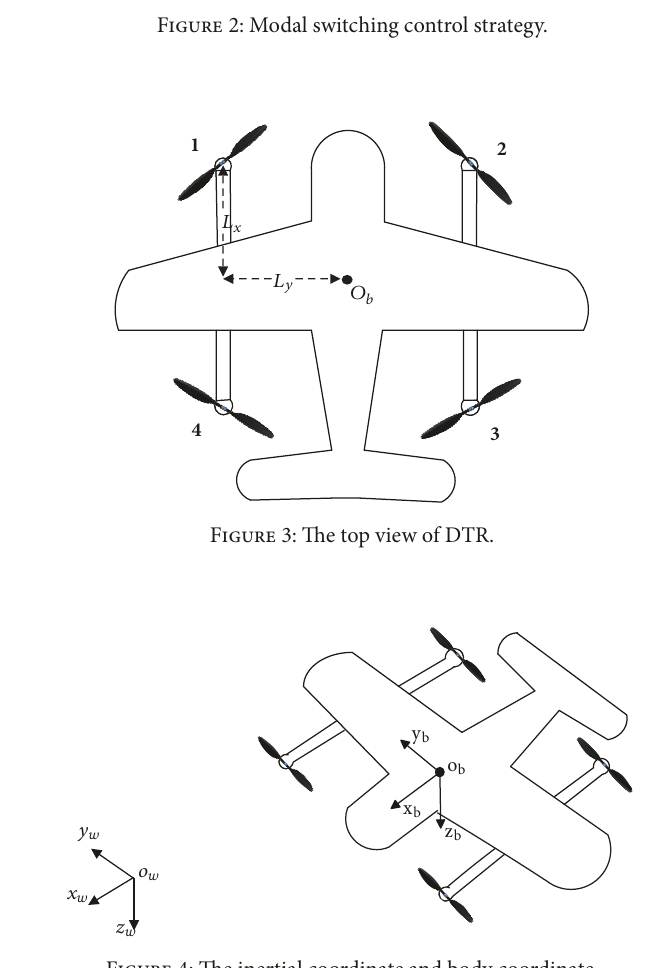
Figure 2: Modal switching control strategy.